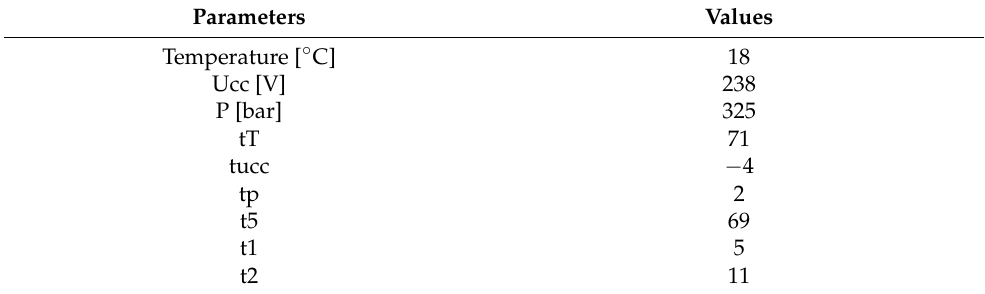
Table 10. The main parameters used in simulation of connection process of the circuit-breaker.